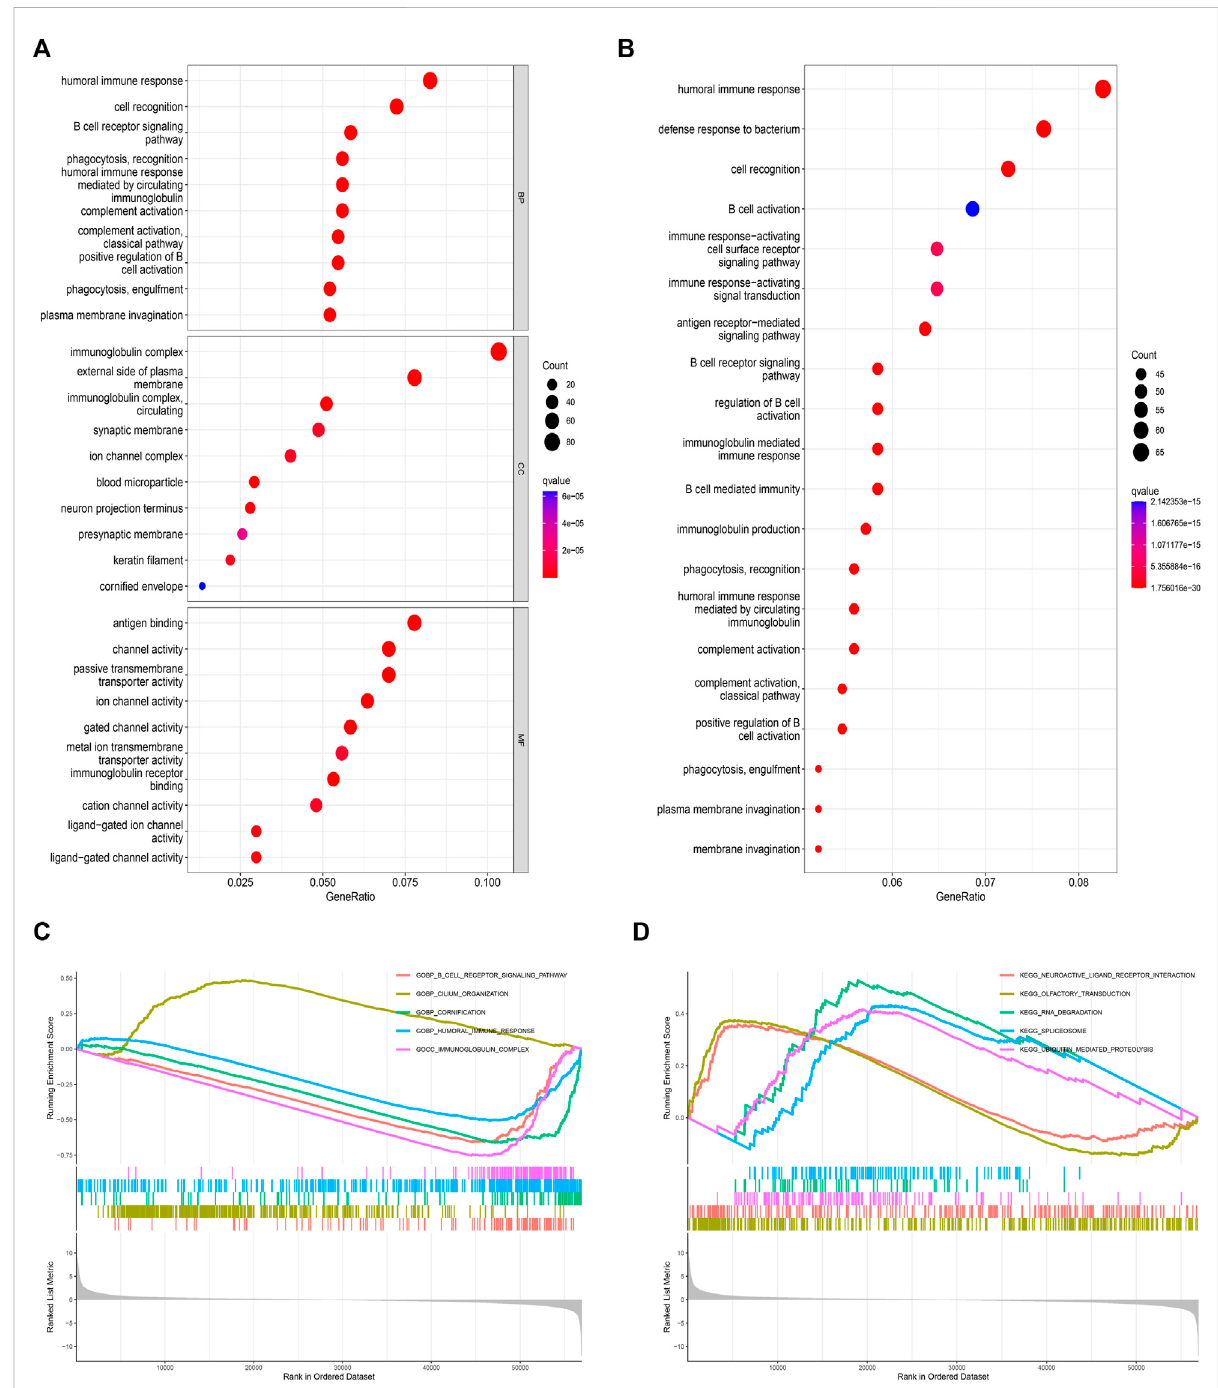
Enrichment analysis of two groups of differentially expressed genes in PAIP2. (A) : GO enrichment analysis of differential genes. (B) : KEGG enrichmentanalysis of differential genes. (C) : GSEA analysis based on GO analysis. (D) : GSEA analysis based on KEGG analysis. (Circle size represents the proportion of genes in this biological process or signal